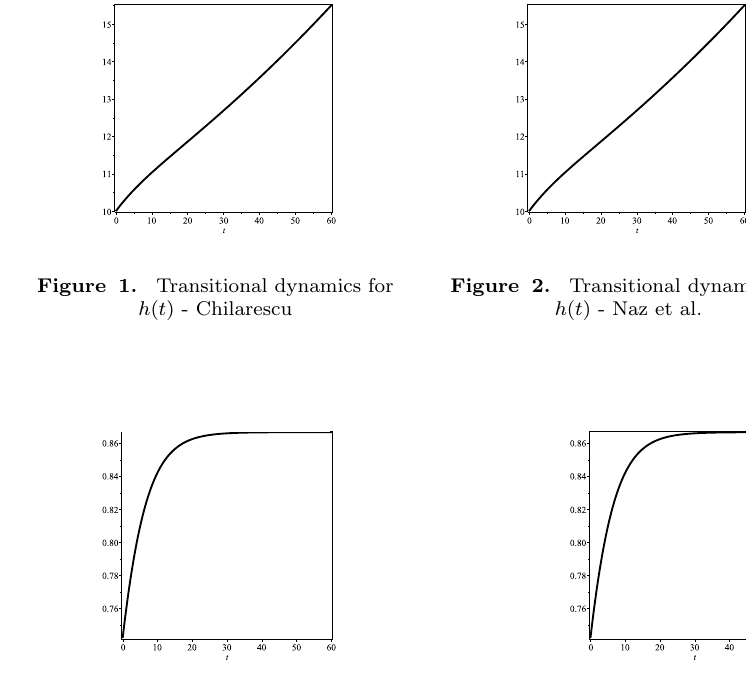
Figure 3. Transitional dynamics for u ( t ) - Chilarescu